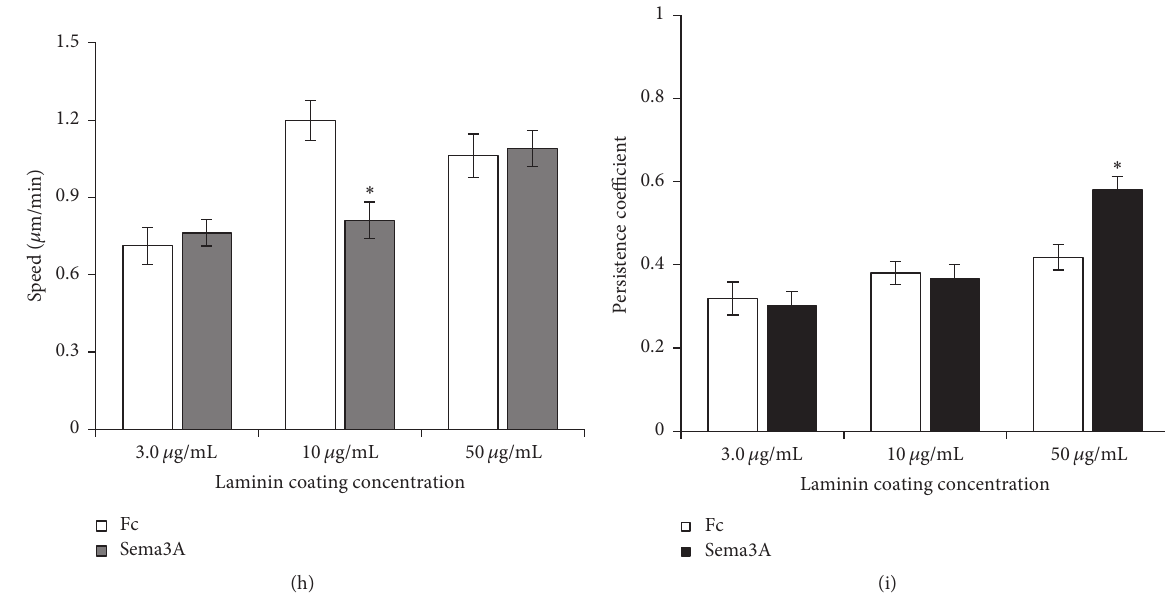
Figure 2: Sema3A regulates cell speed, but not persistence, to alter motility dynamics on collagen and fibronectin, but not laminin. ((a)–(c)) Rose plots showing the migration trajectories of 10 representative tracks for collagen (a), fibronectin (b), and laminin (c) on substrata coated with low, intermediate, and high concentrations of ECM. Scale bar = 10 𝜇 m. Average cell speed and directional persistence were measured for collagen ((d) and (e)), fibronectin ((f) and (g)), and laminin ((h) and (i)). Sema3A enhanced motility at lower coating concentrations of both collagen and fibronectin but inhibited motility at higher coating concentrations of collagen and fibronectin. Interestingly, Sema3A inhibited motility on at intermediate coating concentrations of laminin. Graphed data represent the mean ± SEM from a minimum of 30 cells from four independent experiments. ∗ 𝑝 < 0.001 , ∗∗ 𝑝 < 0.005 , and ∗∗∗ 𝑝 < 0.01 indicate statistical difference relative to IgG1 Fc control; two-sample 𝑡